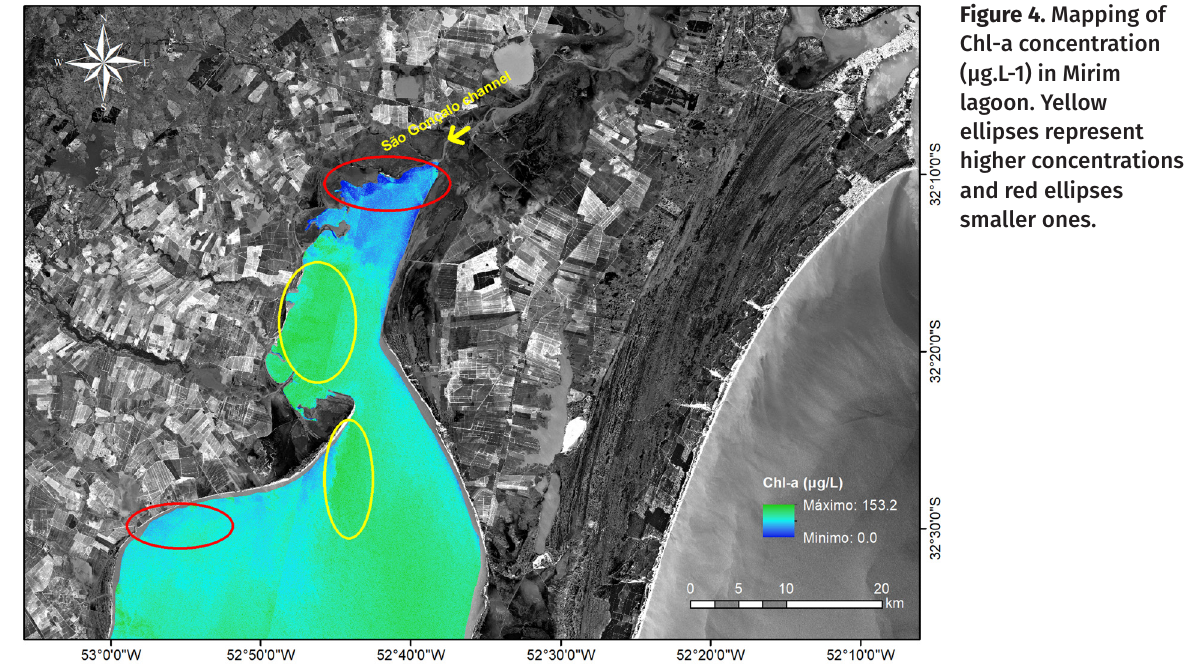
Figure 4. Mapping of Chl-a concentration (μg.L-1) in Mirim lagoon. Yellow ellipses represent higher concentrations and red ellipses smaller